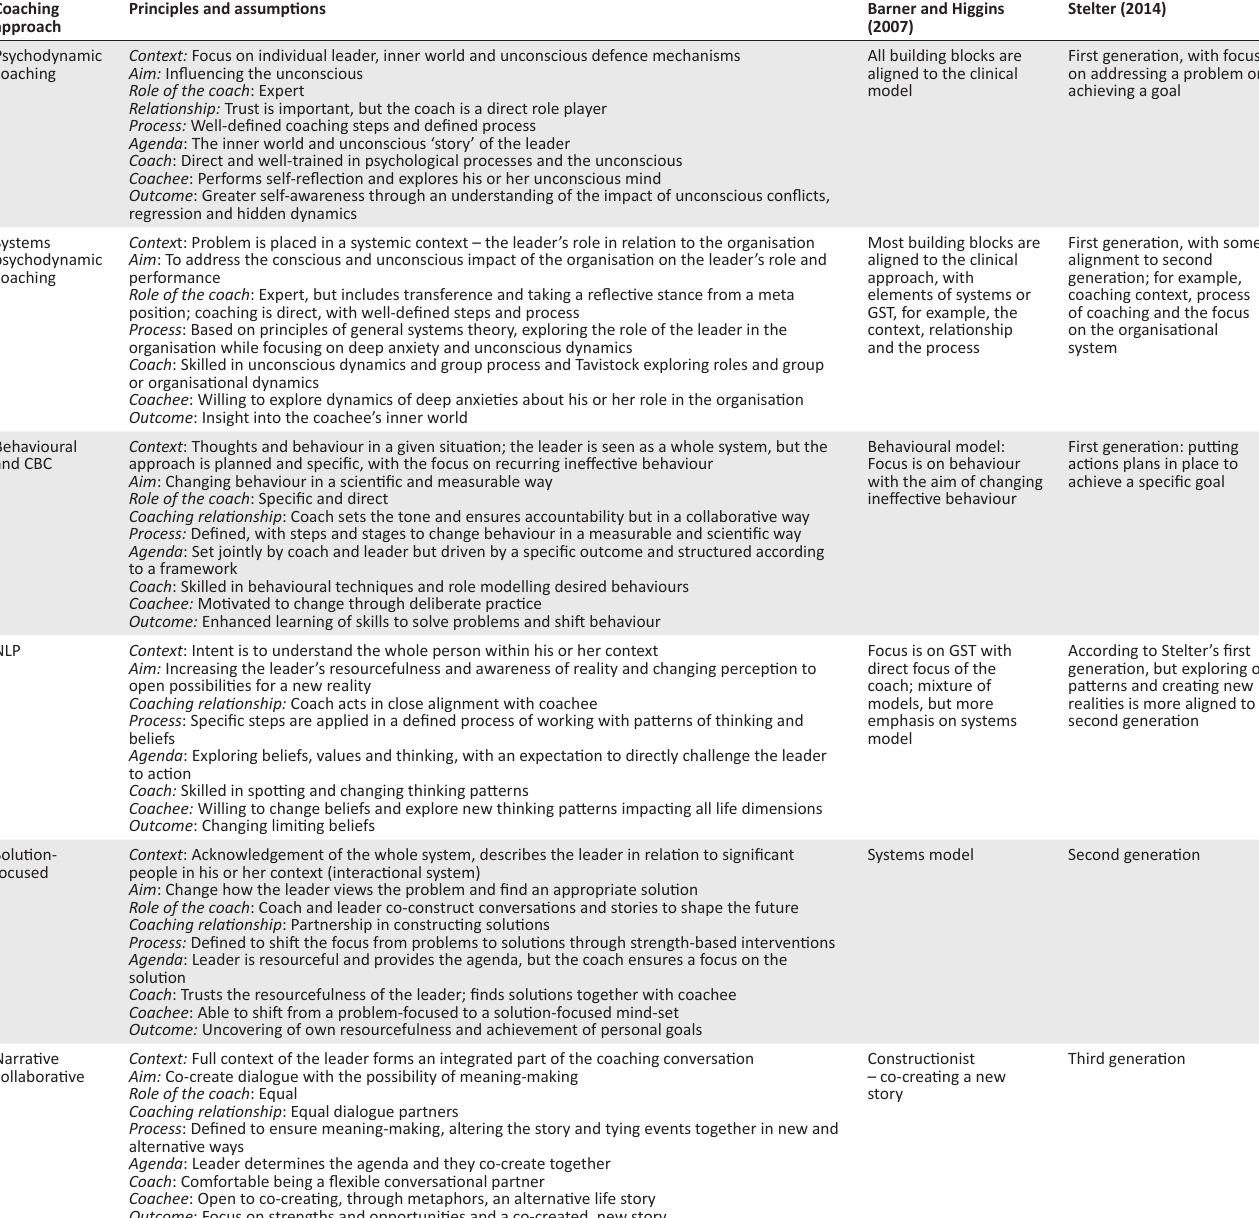
TABLE 1: Coaching approaches’ key differentiating principles and